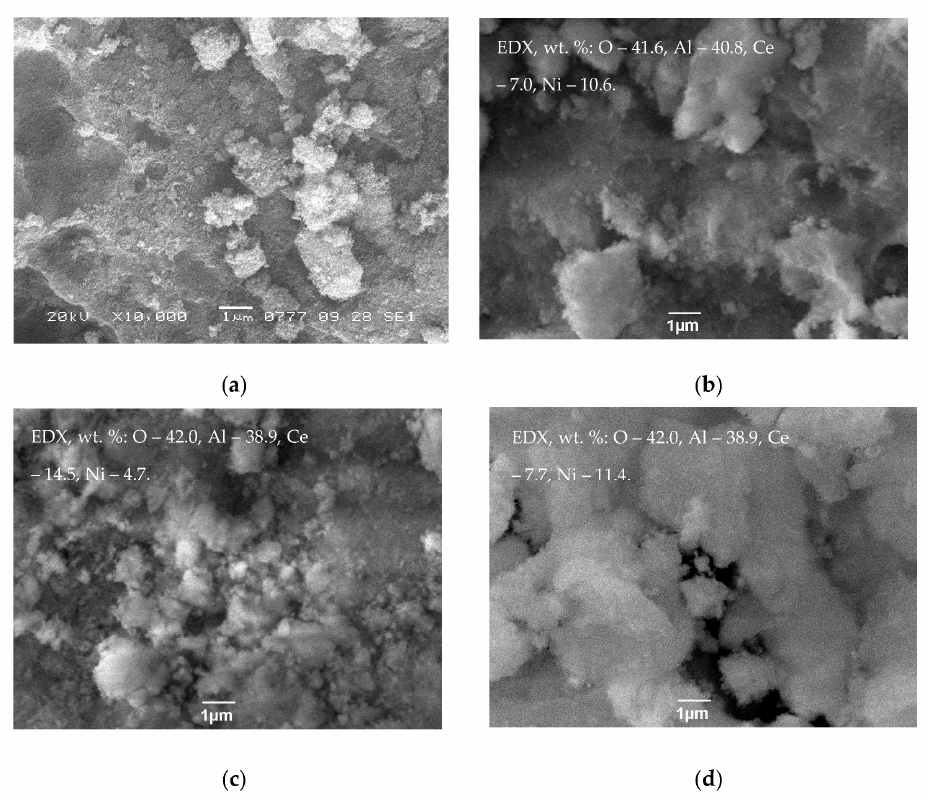
Figure 3. SEM images of Al 2 O 3 support ( a ), 20Ce 0.2 Ni 0.8 O 1.2 /Al 2 O 3 -CI ( b ), 20Ce 0.5 Ni 0.5 O 1.5 /Al 2 O 3 -SG ( c ), and 20Ce 0.2 Ni 0.8 O 1.2 /Al 2 O 3 -SG ( d ) catalysts after calcination ( a – c ) and subsequent reduction ( d ).